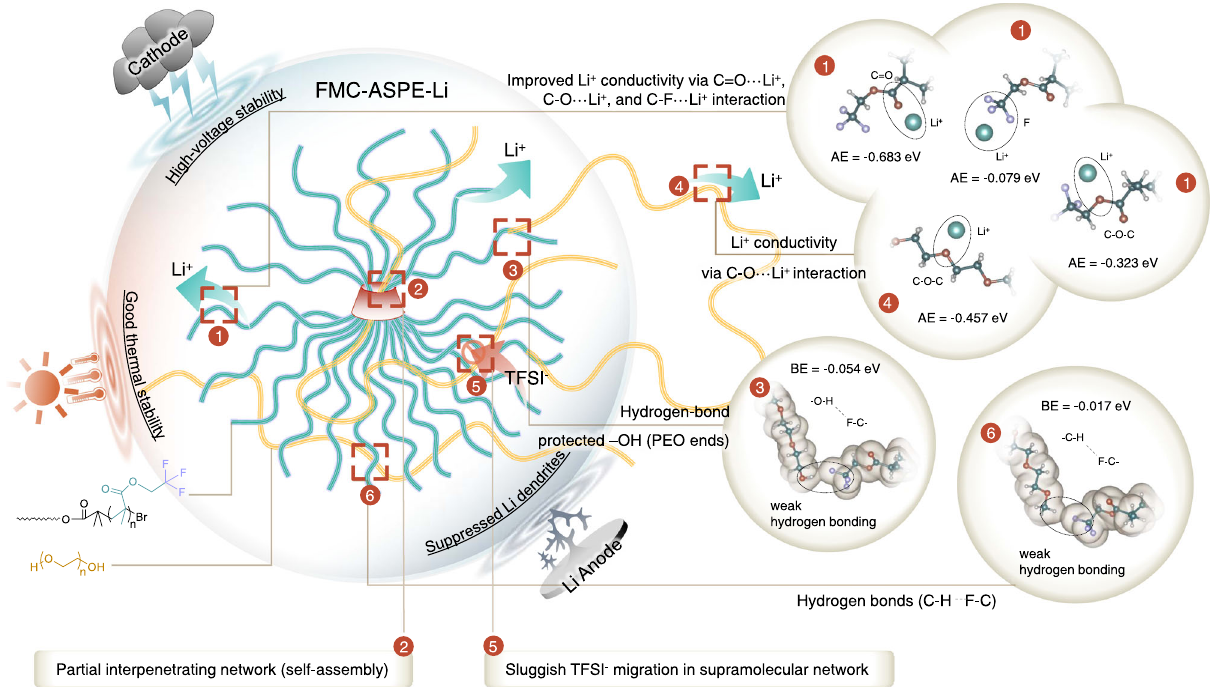
Fig. 4 Schematic of the interactions in the FMC-ASPE-Li membrane. The macromolecule – macromolecule and macromolecule – ion interactions are highlighted with red squares and serial numbers (Nos. 1 – 6) to supplement the DFT calculation results. Four polar groups are demonstrated to synergistically improve Li + movement (higher Li + conductivity and higher Li + transfer number). In addition, two kinds of weak hydrogen bonds in FMC- ASPE-Li are bene fi cial for lowering crystallinity, improving mechanical strength, protecting the end hydroxyl of PEO from oxidation/reduction, hindering TFSI − anion motivation, and improving the thermal stability of the polymer electrolyte. The adsorption energy (AE) between the polar groups and Li + and the bond energy (BE) of the weak hydrogen bonds are annotated in the fi